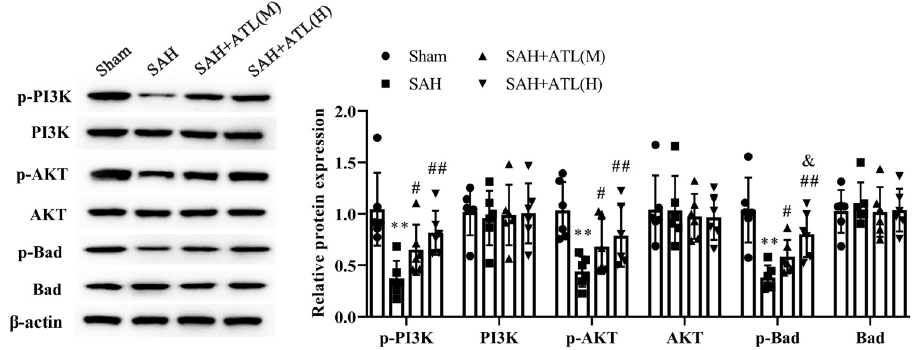
Fig 6. Effects of ATL on the PI3K/Akt signaling pathway at 72h after SAH. Protein expression of p-PI3K, PI3K, Akt, p-Akt, p-Bad, and Bad among each group of the ipsilateral temporal cortex at 72 h after SAH. Data are represented as the mean ± SD. �� p < 0.01 vs. sham group; # p < 0.05 and ## p < 0.01 vs. SAH group. n = 6, the number of animals.